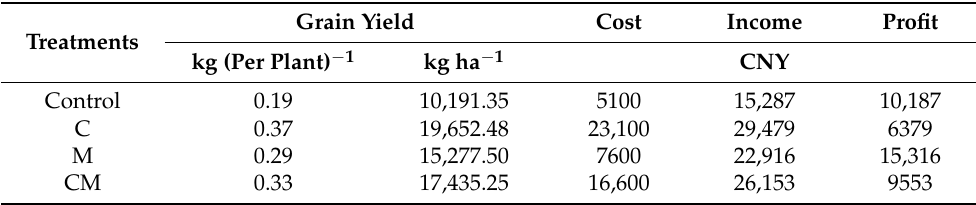
Table 5. Effects of application of 20 t ha − 1 biochar and 5 t ha − 1 Poultry manure on summer maize yield and economic benefits (cost, income, and